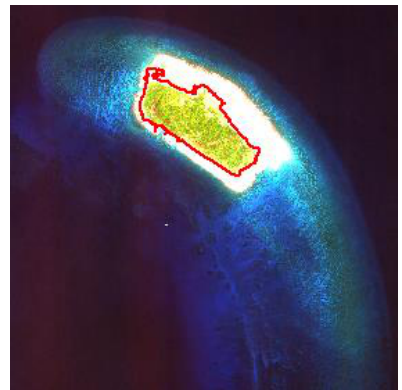
Figure 1 Result of extracting edge line by Canny algorithm